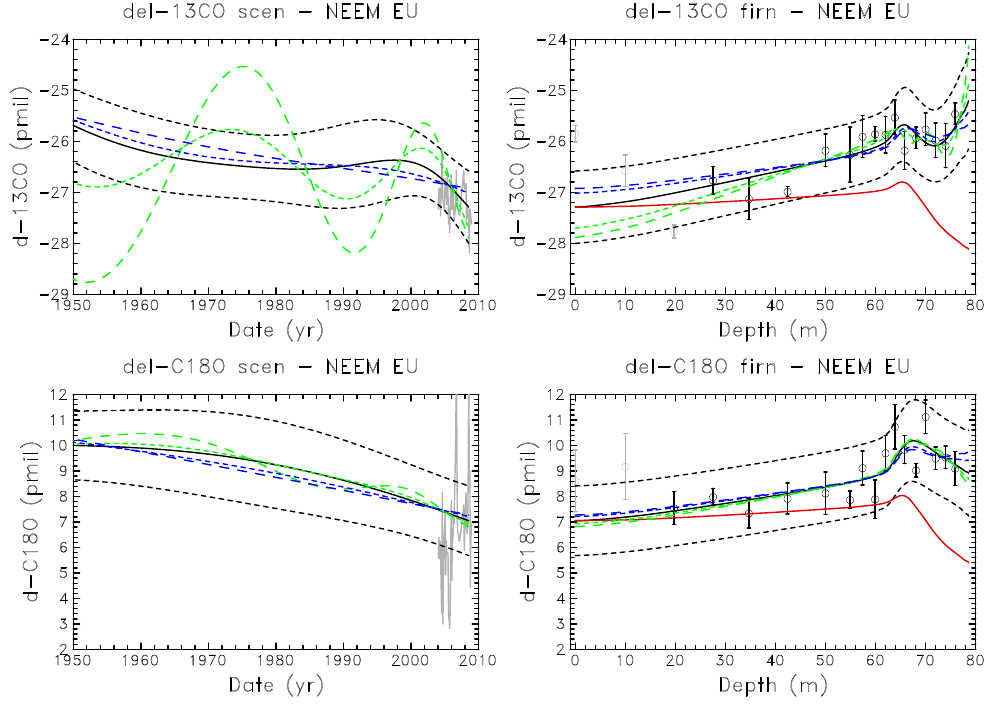
Fig. 4. Best estimate trends of CO isotopes and influence of the regularization factor. Best estimate time trends (in black) and the resulting 805 isotopic ratios in firn are the same as in Fig. 4. The red lines on the right panels show the effect of the CO trend scenario with constant atmospheric isotopic ratio. Blue lines show the effect of increasing the weight of the regularization term by a factor of 10 (short dashed lines) and 100 (long dashed lines). Green lines show the effect of decreasing the weight of the regularization term by a factor of 10 (short dashed lines) and 100 (long dashed lines). The circles with error bars on the right panels show the measurements, and those in grey were not used in the scenario reconstruction. Grey lines on the left panels show the de-seasonalized atmospheric trends in Iceland (Wang et al., 2012).